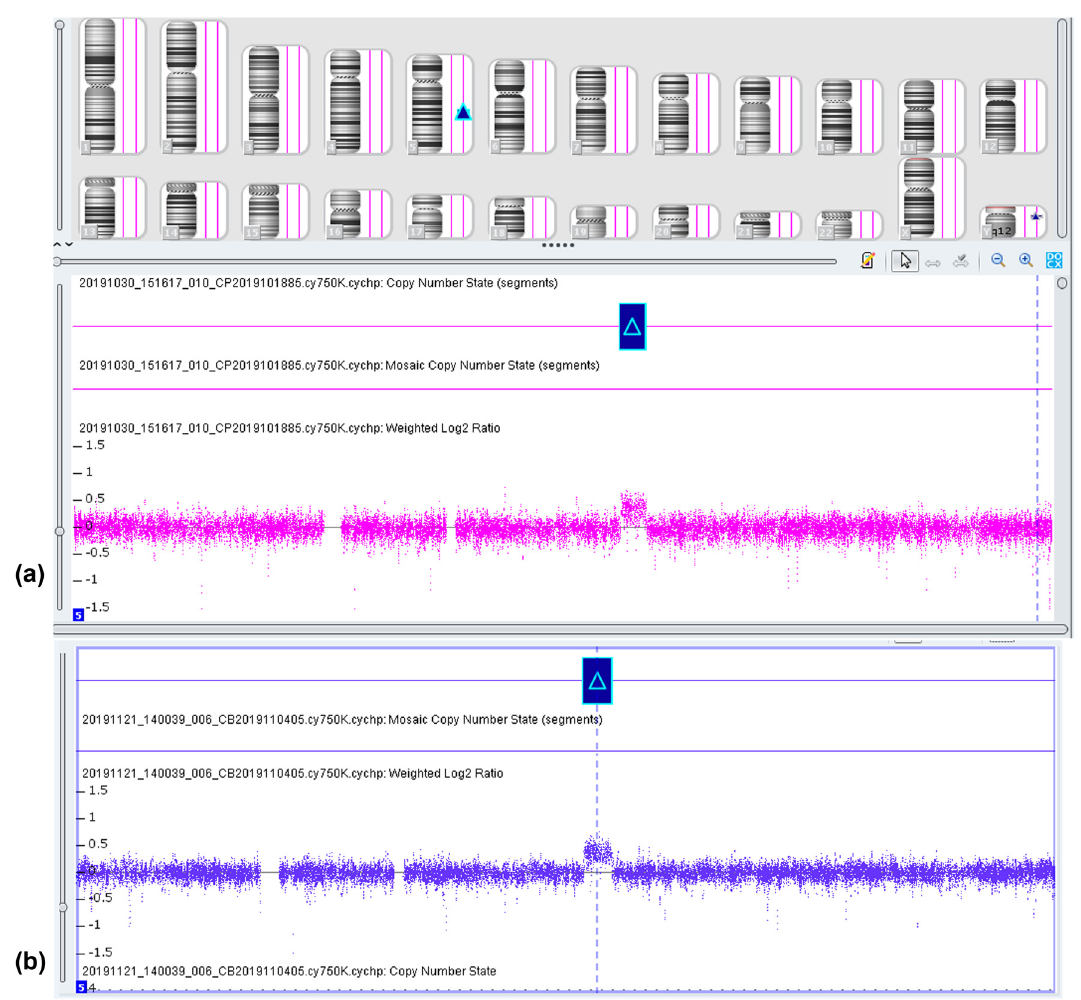
Figure 2: ( a ) Chromosomal microarray analysis ( CMA ) array on uncultured amniocytes depicted 5q21.1q21.3 ( 101116629 – 105838444 ) microduplication. ( b ) CMA array on peripheral blood depicted 5q21.1q21.3 ( 101070989 – 105838444 )